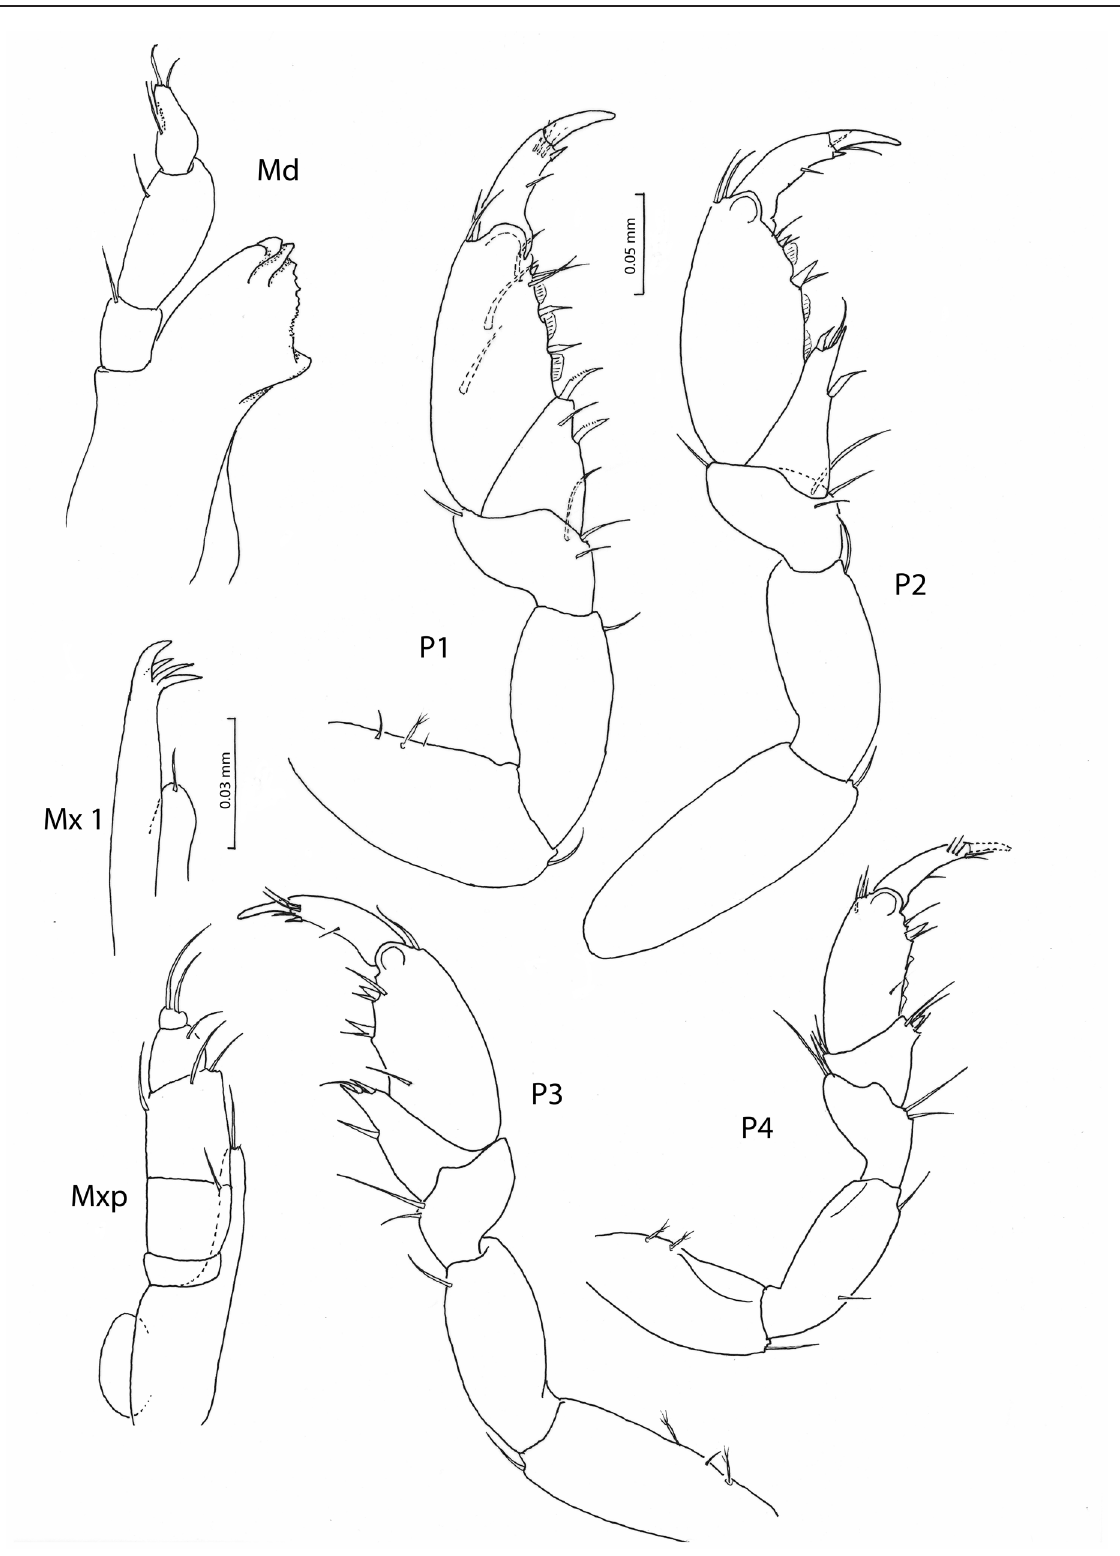
Fig. 11. Kupellonura macaroni sp. nov., holotype, immature adult (MZB Iso 102). Abbreviations: Md = mandible; Mx 1 = maxilla 1; Mxp = maxilliped; P1–P4 = pereopods